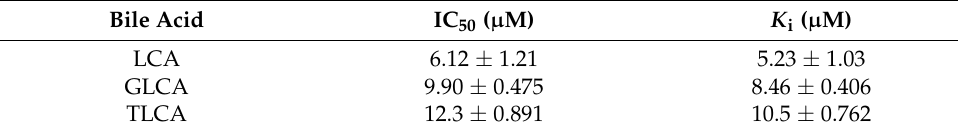
Table 1. IC 50 and K i values of LCA, GLCA, and TLCA.